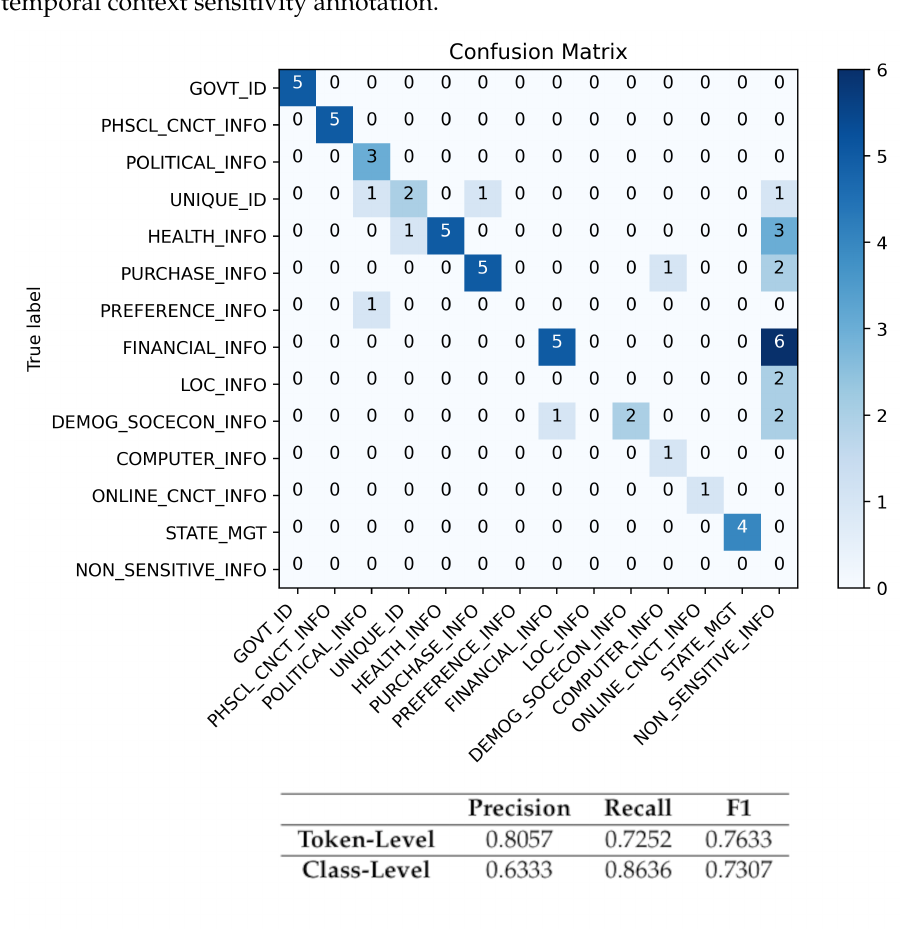
Figure 4. Confusion matrix for temporal context